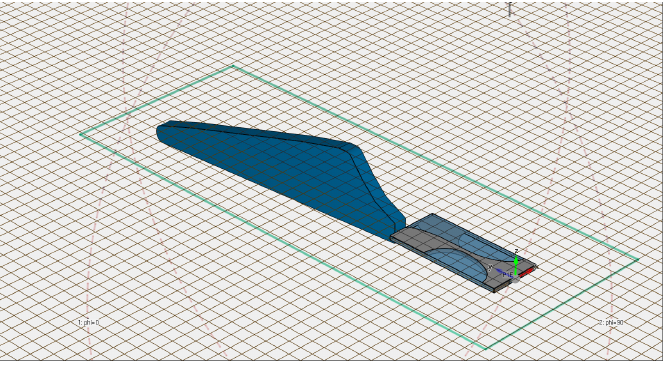
Figure 20. The simple blade rotates 90 ◦ in a clockwise direction.